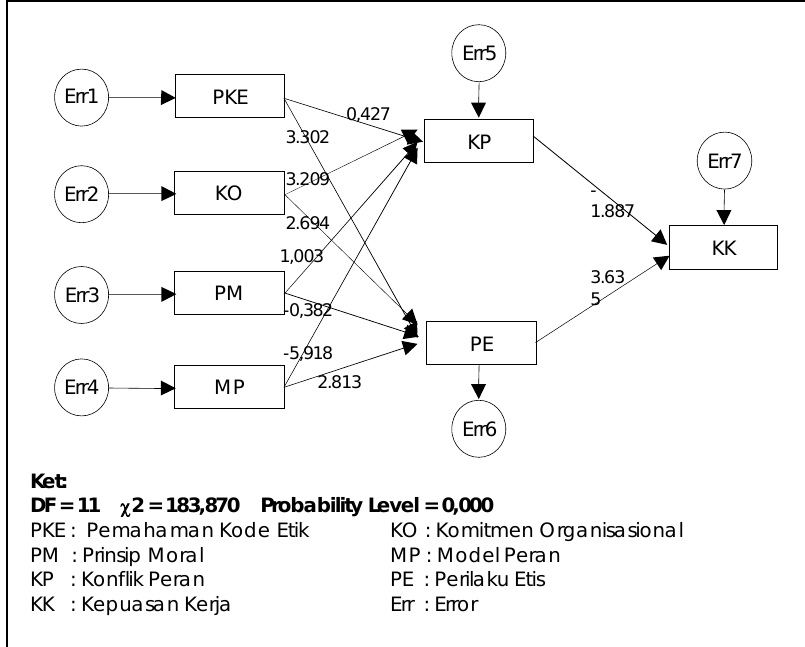
Gambar 1. Model Penelitian dan Critical